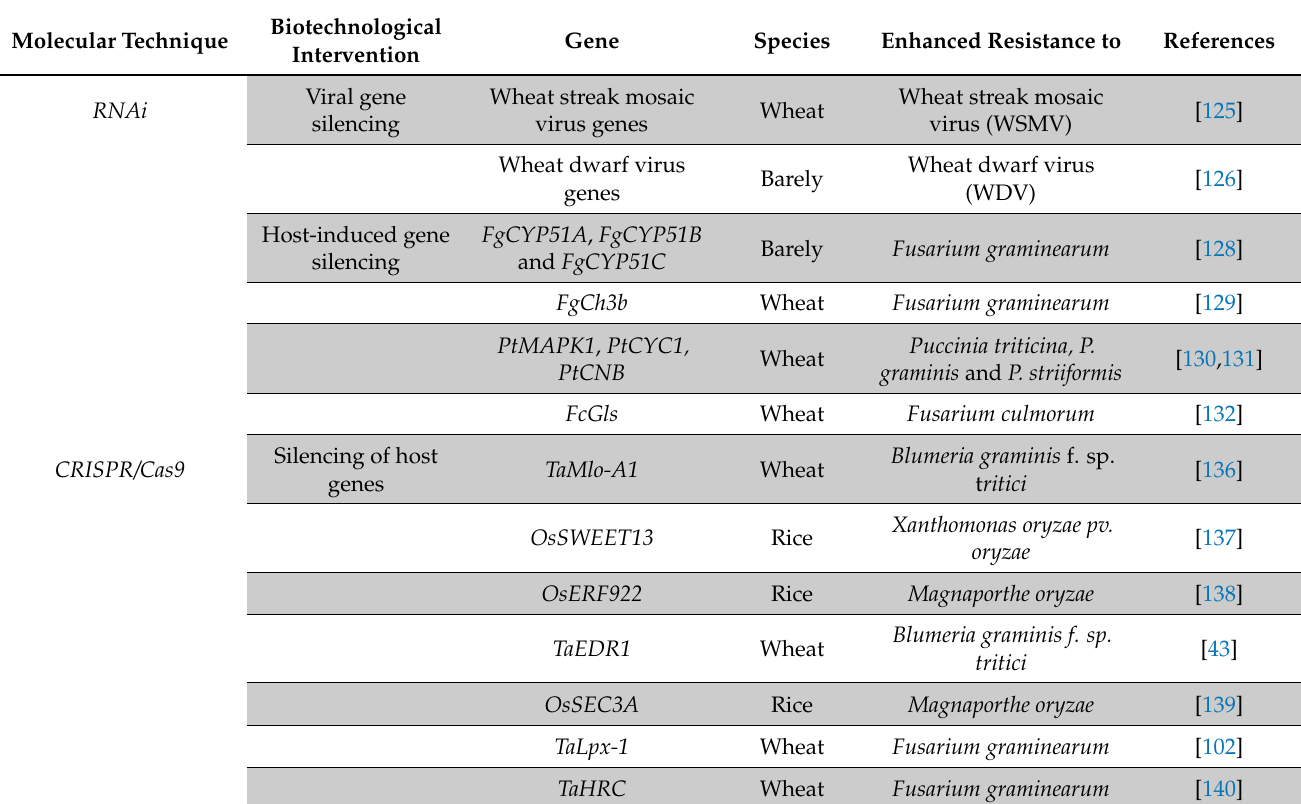
Table 2. Examples of gene expression or editing techniques to increase disease resistance in cereals. Molecular Technique